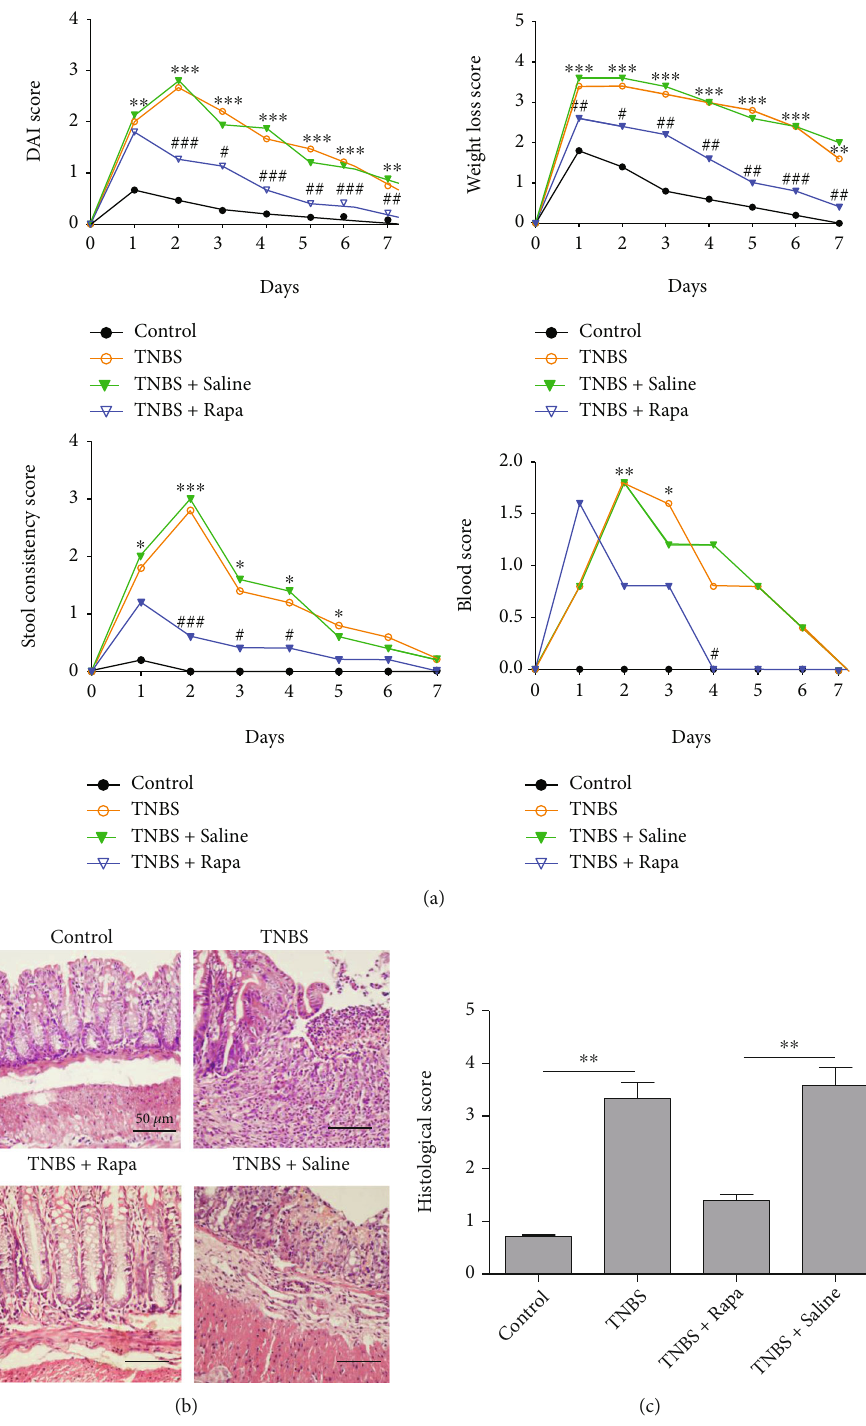
Figure 1: Rapamycin protects against TNBS-induced colitis in mice. (a) After being treated with TNBS (100 μ l of 2.0%), mice were gavaged with rapamycin (3 mg/kg/day) or saline (100 μ l) for 7 days. Disease activity index (DAI) scores were used to evaluate the severity of colitis. The DAI was determined by scoring changes in weight, hemoccult positivity, or blood trace and stool consistency. ∗ TNBS vs. control; # TNBS +Rapa vs. TNBS+saline. ∗∗ P < 0 : 01, ∗∗∗ P < 0 : 001, # P < 0 : 05, ## P < 0 : 01, and ### P < 0 : 001 . (b) H&E staining was used to examine the histological changes of colonic mucosa ( × 100). (c) The histological scores were calculated to evaluate the severity of colonic mucosa in fl ammation ( n = 5 per group, ∗∗ P < 0 : 01